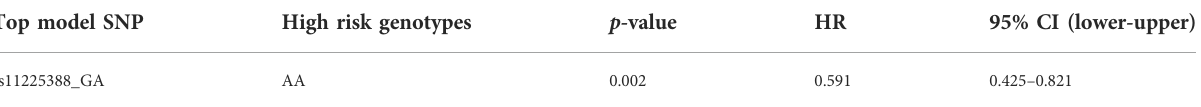
TABLE 1 Multivariable Cox regression analysis result for the signi fi cant 1-way Cox-MDR model in the MMP dataset (overall survival). Top model SNP